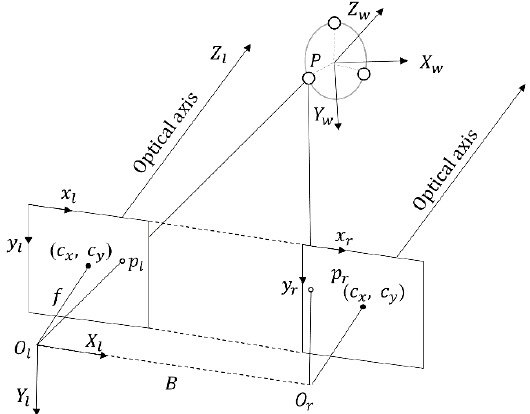
Figure 10. The schematic diagram of the binocular vision algorithm.